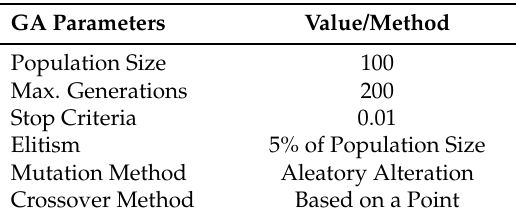
Table 1. GA-LQR Simulation Parameters.